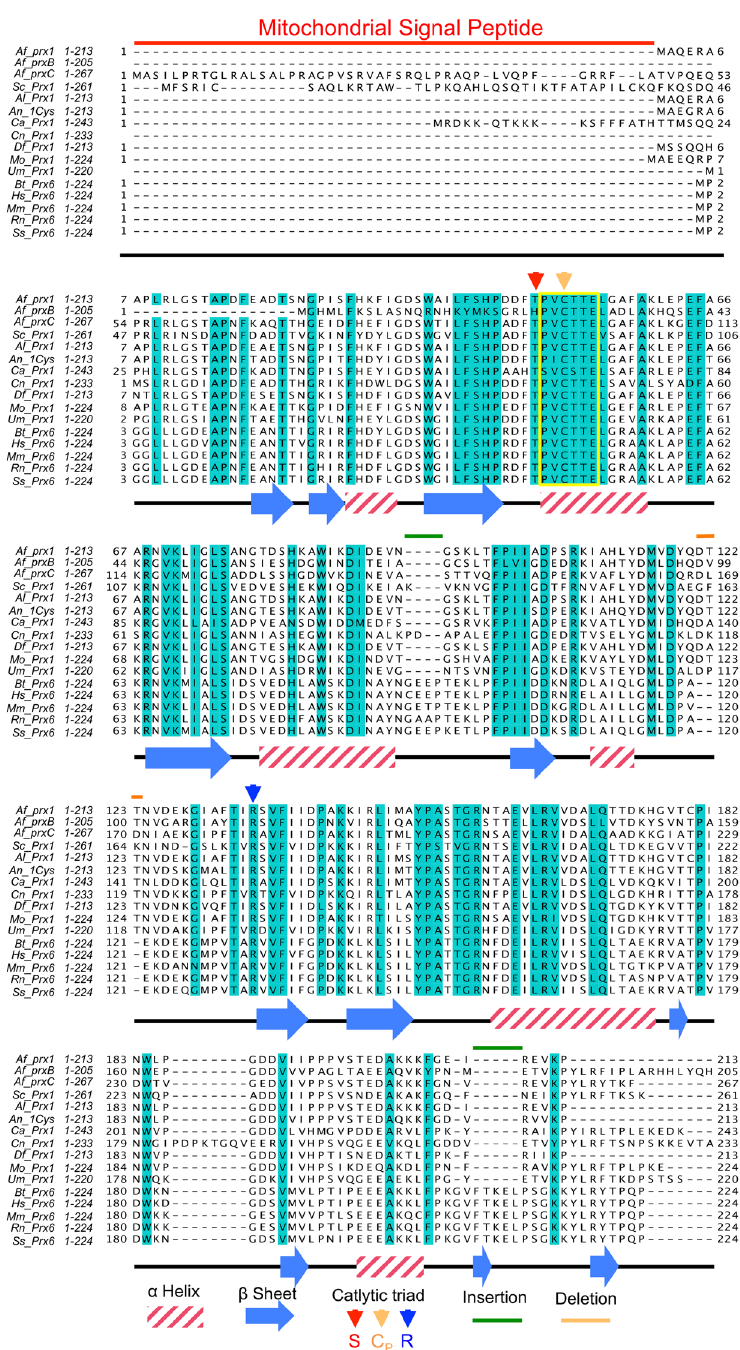
Figure 1. Sequence alignment of 1-Cys Prx from A . fumigatus , other fungi and mammals. Identical residues among sequences are depicted in blue. The yellow box denotes the conserved motif PVC P TTE in the Prx6 sub- class. The colored arrowheads indicate the conserved amino acids of the catalytic triad: Thr (red), C P (orange) and Arg (blue). The colored bars denote the mitochondria signal peptide (red), residues insertions (green) or deletions (orange). The secondary structure assignments based on the structure of H . sapiens Prx6 (PDB code: 1PRX) are shown below the amino acid sequences. The species abbreviation initials are given in italics and are as follows: Af_prx1 = A . fumigatus prx1 (AFUB_065670); Af_prxB = A . fumigatus prxB (AFUB_062560);